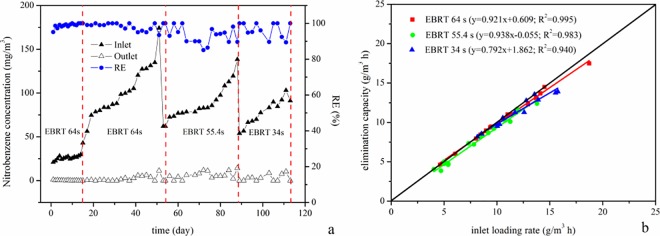
Performance of the biofilters for the removal of NB: effect of the EBRT (a) and the elimination capacity vs. the inlet loading rate (b).